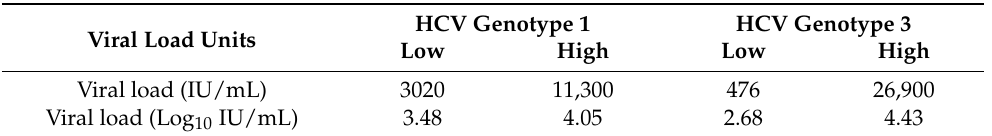
Table 1. Viral load of HCV RNA whole blood dried tube samples used to determine accelerated and real-time stability for use in quality assurance